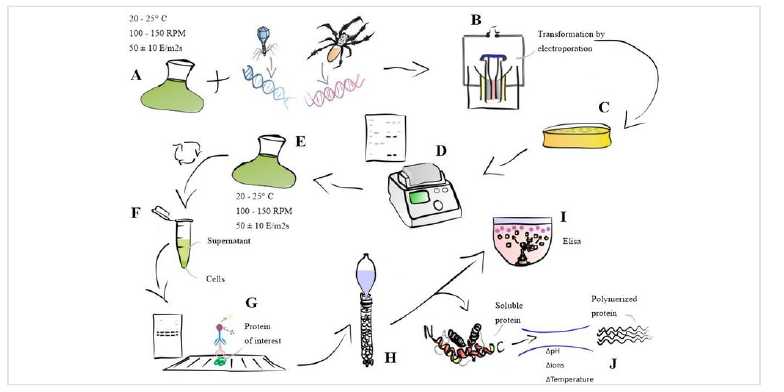
Experimental Flowchart. (A) Wild Cells incubated with built vectors. (B) Wild-cell transformation by electroporation. (C) Selection of mutants resistant to Zeocin. (D) Screening of antibiotic resistant cells by PCR. (E) Cultivation of PCR positive cells. (F) Fractions to be tested for the presence of recombinant proteins. (G) Detection of recombinant proteins present in the fractions by Western Blot. (H) Protein Puri fi cation. (I) Quanti fi cation via ELISA. (J) Spider silk polymerization